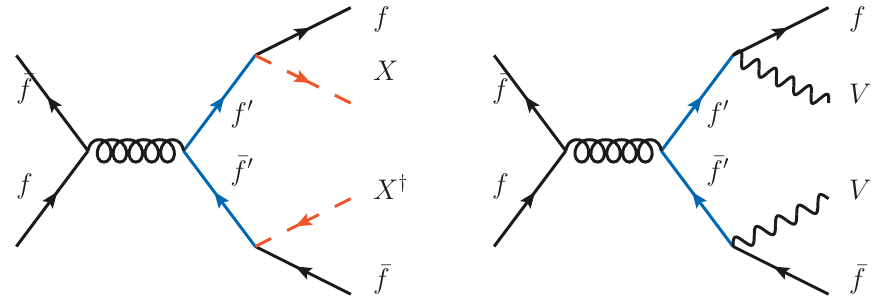
Figure 4 . Typical Feynman diagrams that produce mirror fermions f into SM fermion f and dark matter X or SM gauge boson V